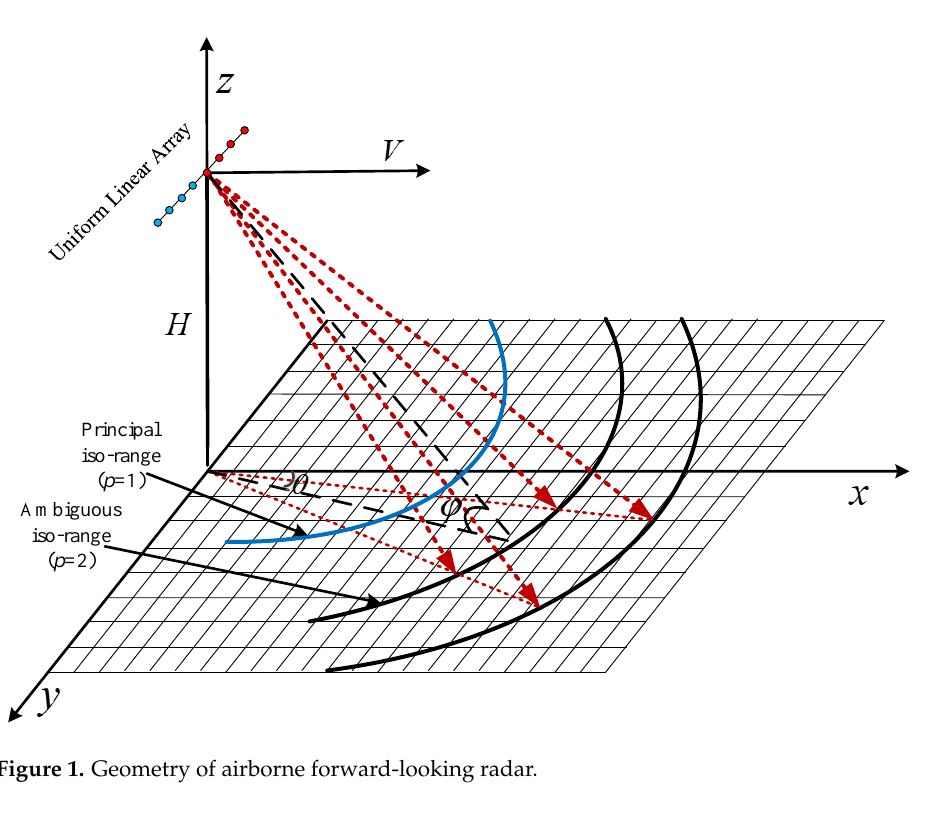
Figure 1. Geometry of airborne forward-looking radar.